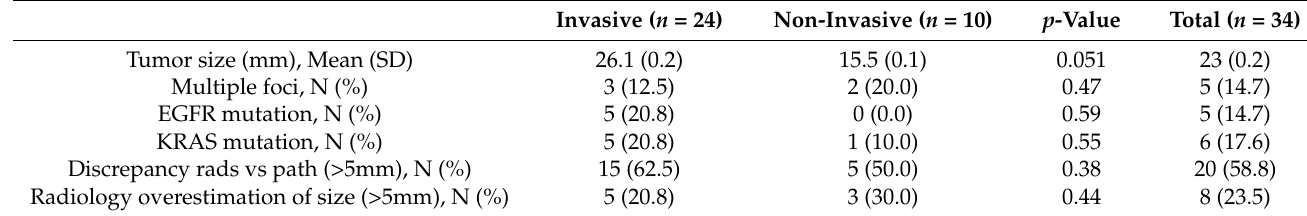
Figure 1. Comparison between the radiological and explanted total tumor size (invasive and nonin- vasive size). ( a ) Correlation between the radiological and explanted tumor size. ( b ) Bland-Altman analysis of the agreement between the two measurements. ( c ) Radiological size can both over- and under-estimate the actual explanted tumor size. Table 4. Pathology features assessed for association with